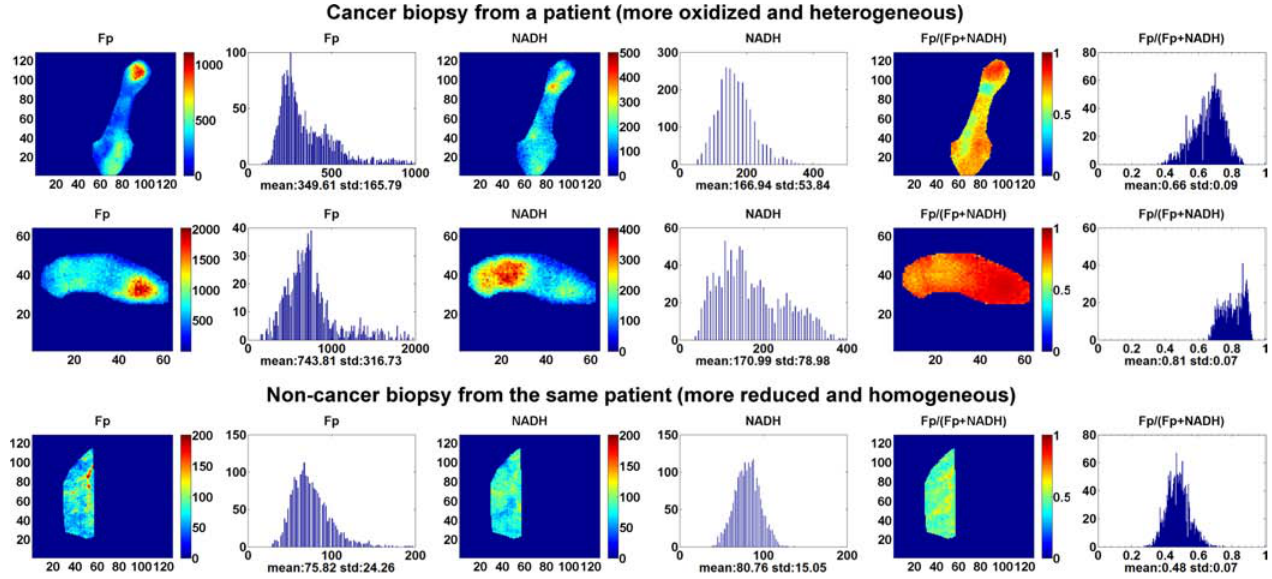
Fig. 1. The typical redox images of the cancerous and non-cancerours breast tissue biopsies from a patient. From left to right: Fp, NADH, and the Fp redox ratios images and the corresponding histograms. The ¯gure is reproduced with permission from Ref.